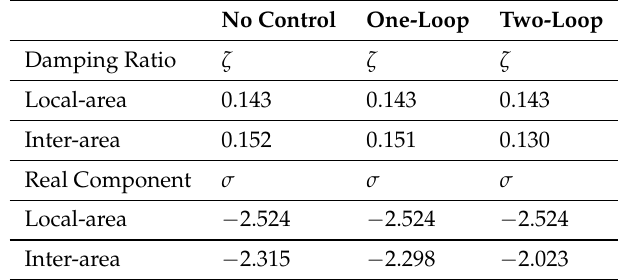
Table 2. Eigenproperties of dominant eigenvalues. Scenario 1—Base